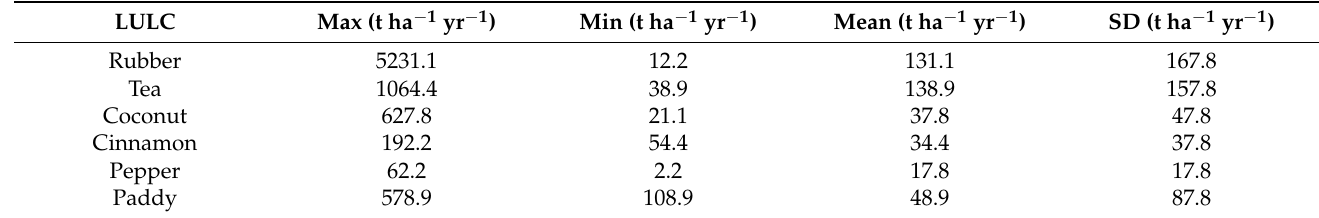
Table 3. Descriptive statistics of soil erosion in each crop